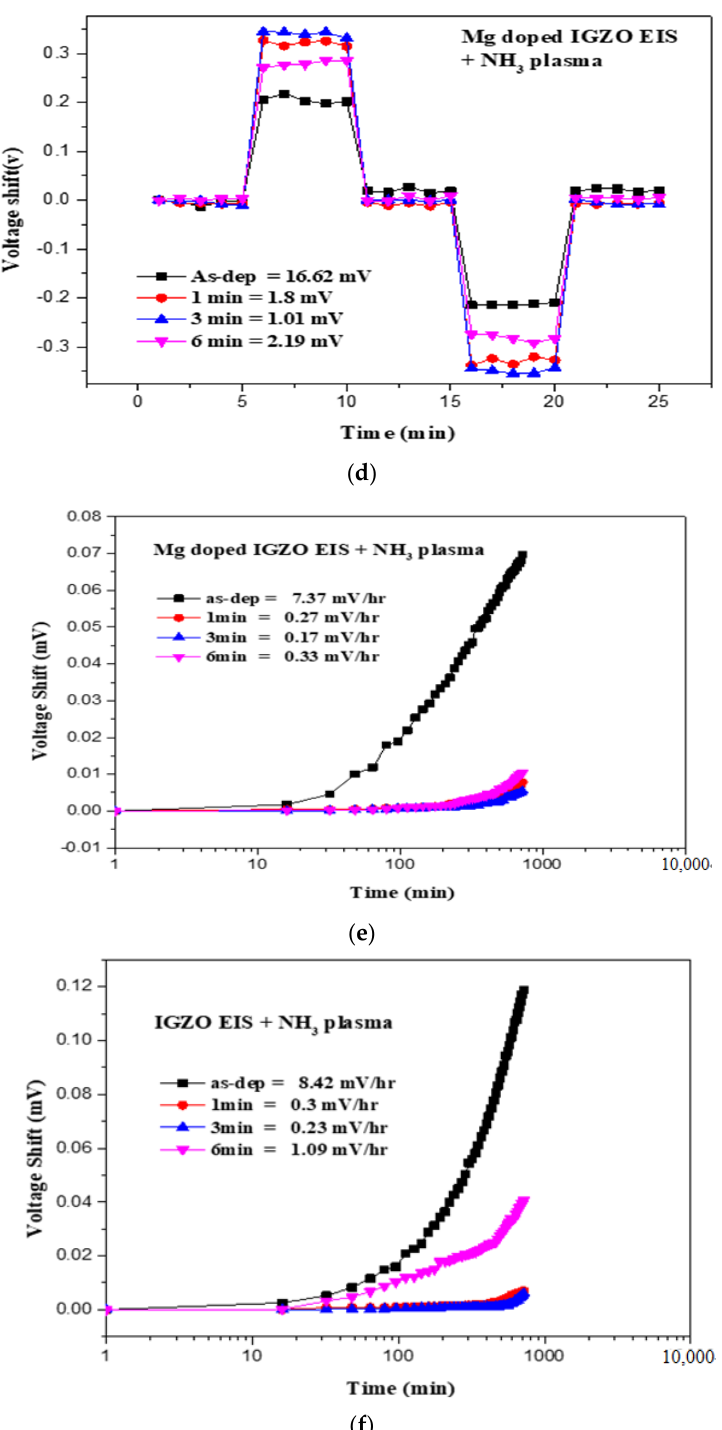
Figure 6. The C-V curves and the extracted pH sensitivity and linearity of the sensing data of ( a ) IGZO with NH 3 plasma treatment for 3 min and ( b ) Mg doped IGZO with NH 3 plasma treatment for 3 min. The hysteresis voltage measurements for ( c ) IGZO with NH 3 plasma treatment for 3 min and ( d ) Mg doped IGZO with NH 3 plasma treatment for 3 min. The drift voltage measurements for ( e ) IGZO with NH3 plasma treatment for 3 min and ( f ) Mg doped IGZO with NH 3 plasma treatment for 3 min.